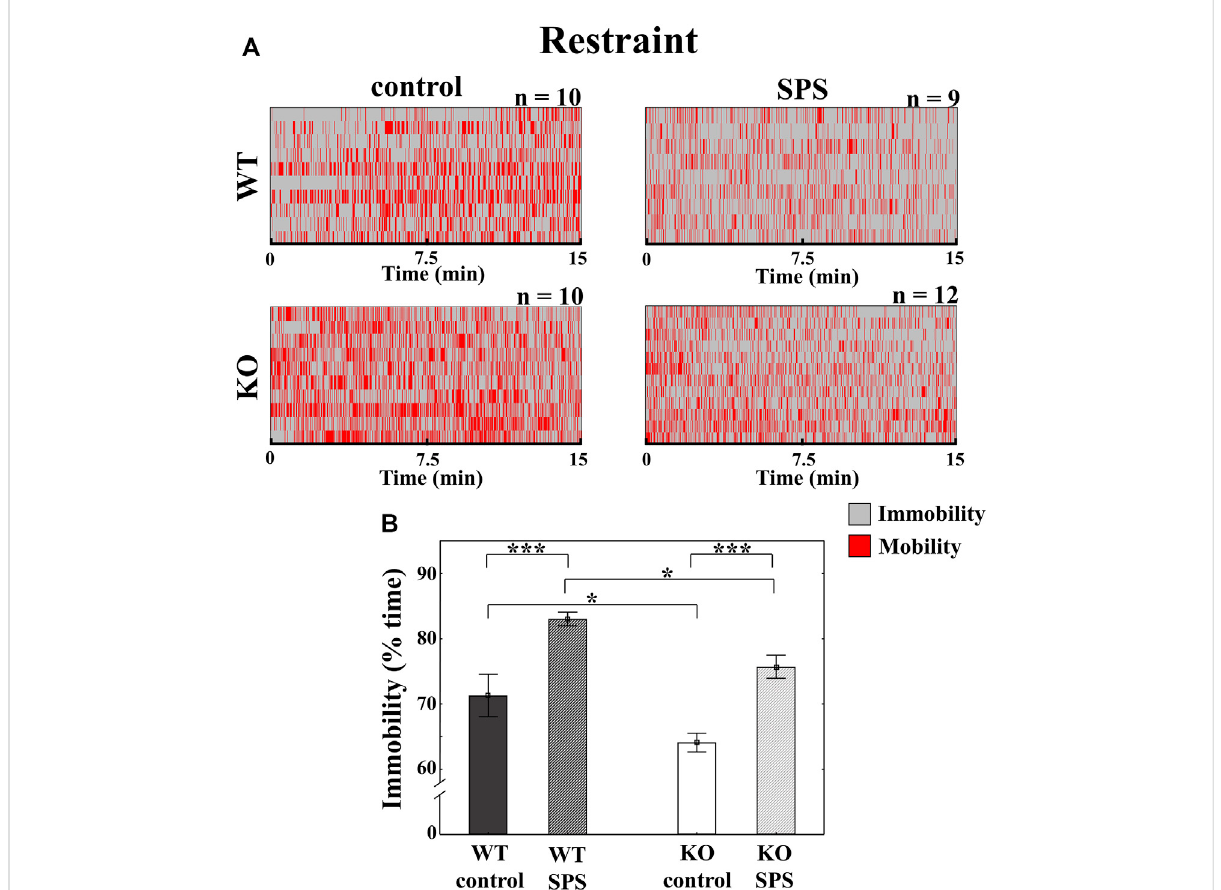
FIGURE 2 Alterations of the behavioral parameters in Trpa1 wild type (WT) and knockout (KO) mice during the restraint stress. Individual values are representedonaGanttdiagram (A). Columnsrepresentthetimeofimmobility (B) (two-wayANOVAfollowedbyTukey ’ s post-hoc test;* p <